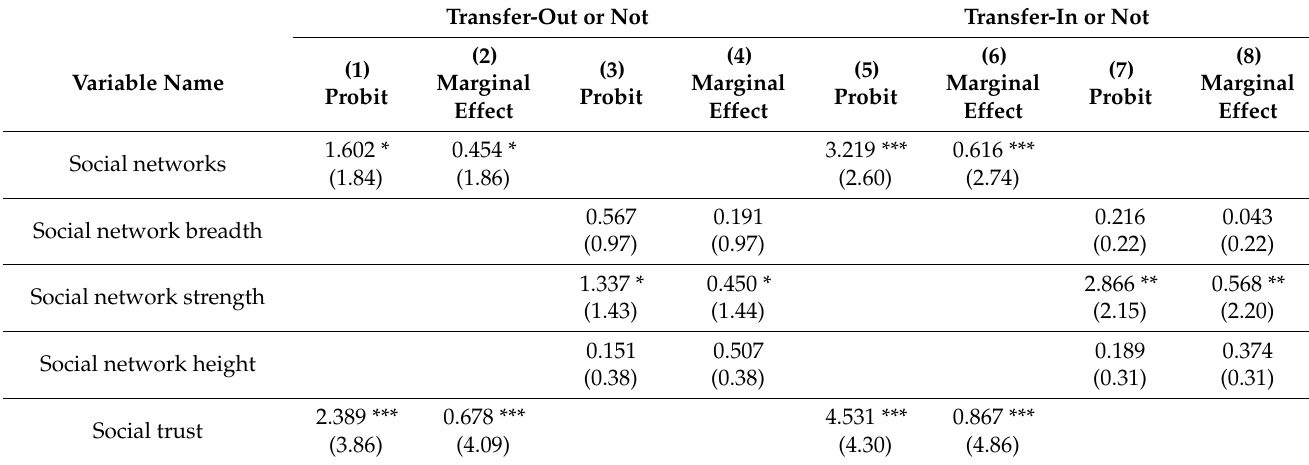
Table 9. Estimation results of the sample model in the Ecological and Cultural Tourism Circle of Western